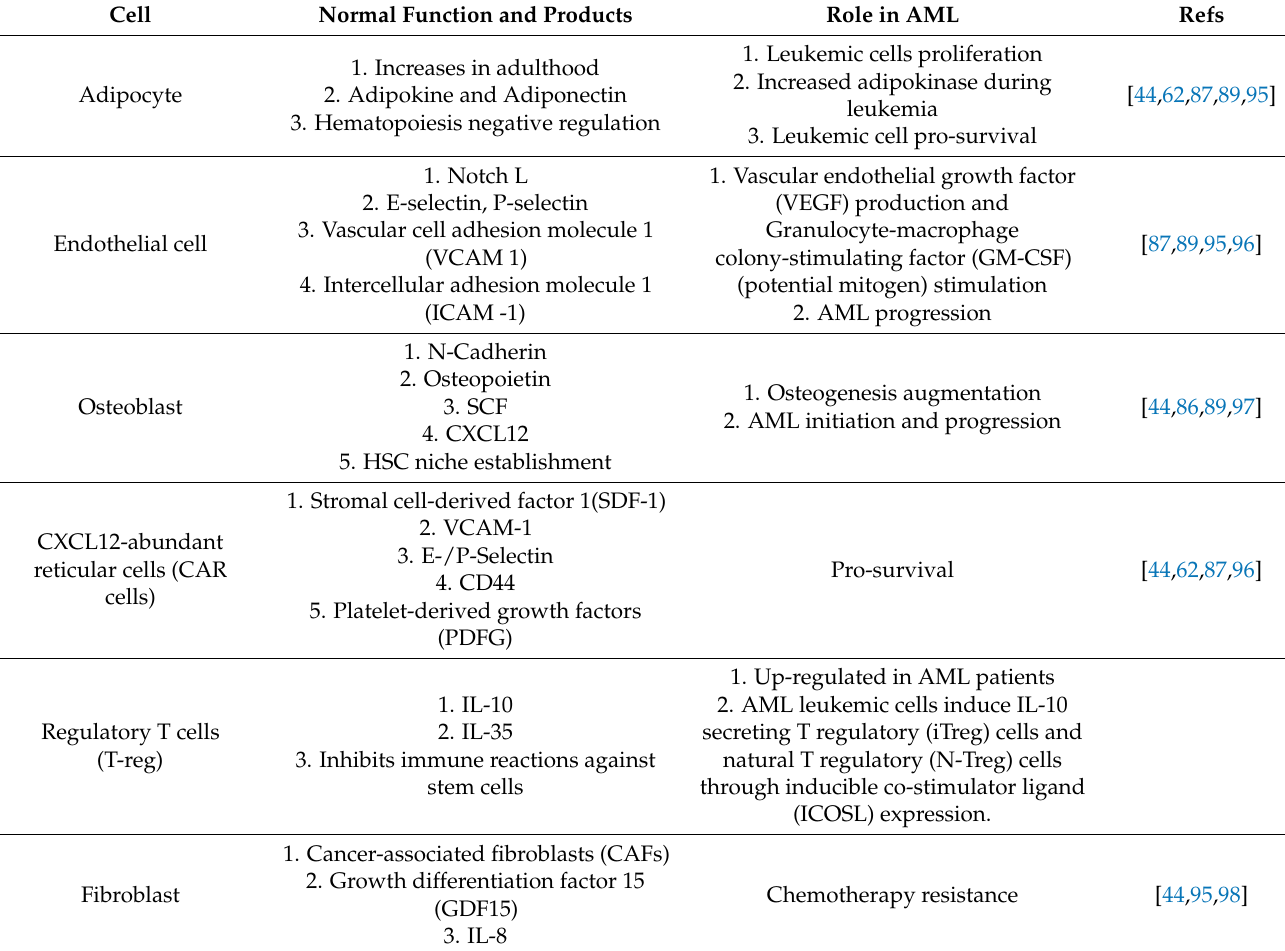
Table 4. The function of various cellular components of the BM in normal and AML status. Cell Normal Function and Products Role in AML Refs